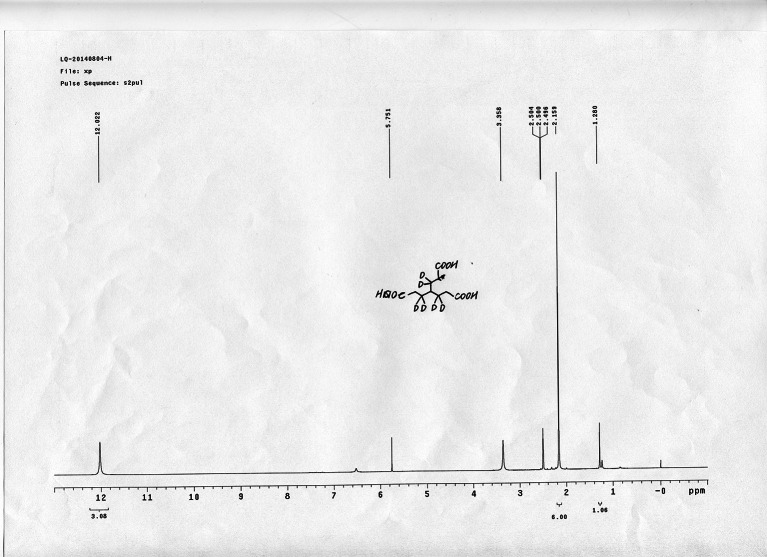
1H NMR spectra of compound 29.